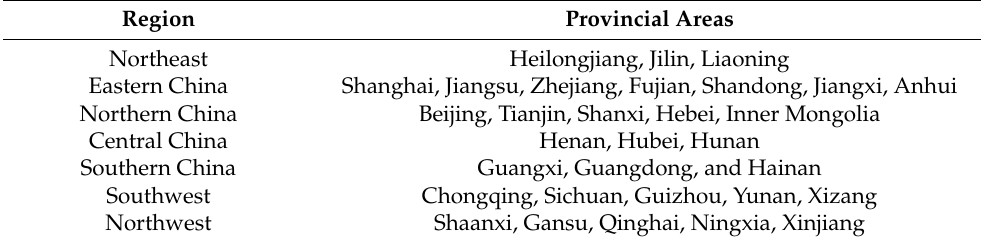
Table 1. Division of China’s 31 provincial administrative regions. Region Provincial Areas Northeast